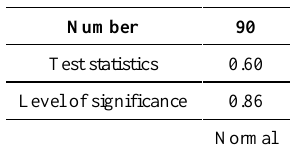
Table 3 . Kolmogorov-Smirnov test.